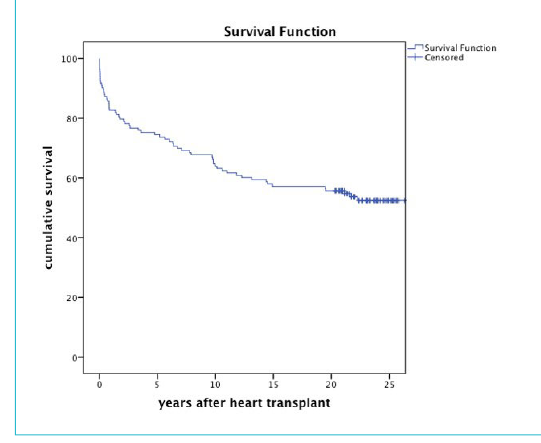
Figure 4: Long-term survival of the first 133 patients transplanted in Zurich from the restart of the programme in 1985 until